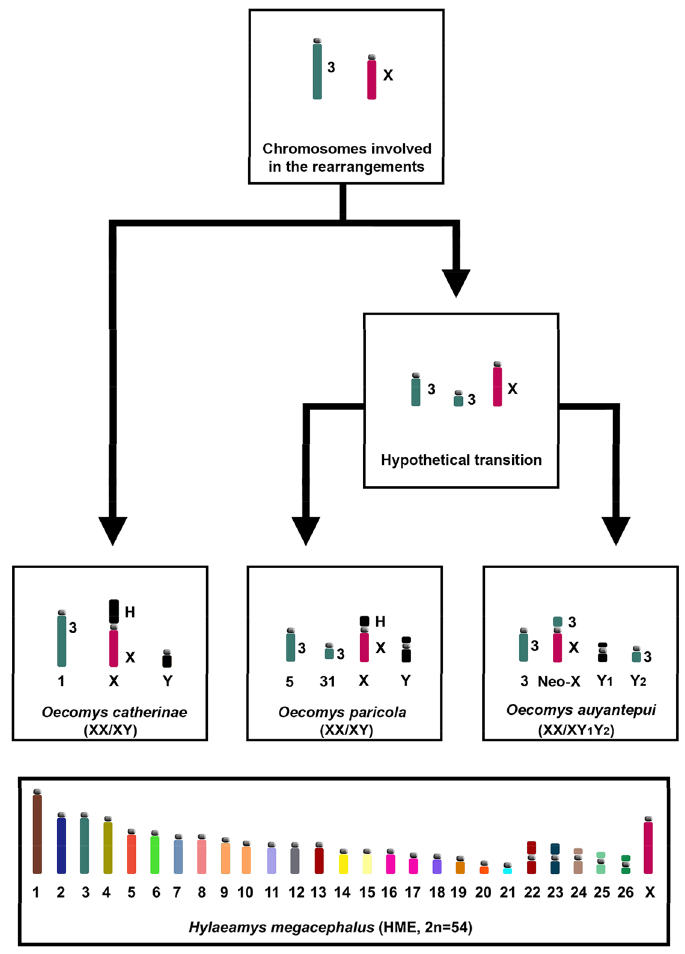
Figure 7. Idiograms of the chromosomes involved in the emergence of a new sex-system (XX/XY 1 Y 2 ) in Oecomys auyantepui (OAU; 2n = 64 ♀ 65 ♂ /FNa = 84), as assessed based on HME probes 54 . Idiograms in black (Y and Y 1 ) were evaluated only by classical cytogenetics. Arrows show direction of chromosome change. We used O. paricola -cytotype A 50 and O. catherinae -Pará 47 as representatives of their respective species. Numbers below idiograms correspond to the identification of the chromosomal pair; numbers beside idiograms correspond to the HME probes. The bottom box encompasses an idiogram of HME karyotype previously elaborated 58 and adapted in the present study. Each HME chromosome is shown with a single color, except the pairs (9,10), (13,22) and (16,17), which have one color each. (H) Indicates large block of constitutive